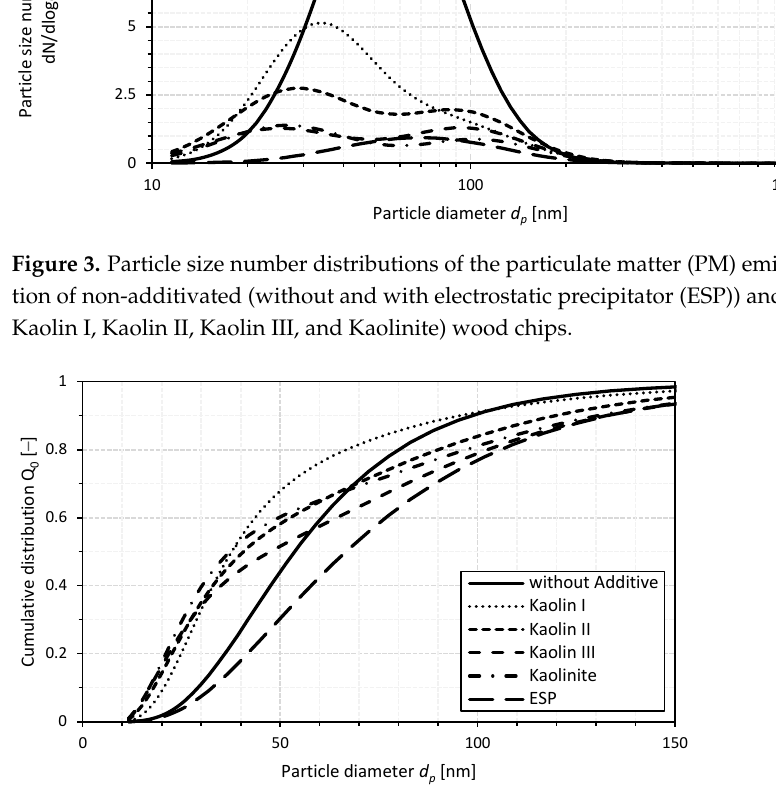
Figure 4. Cumulative particle size number distributions of the particulate matter emissions (PM) for the combustion of non-additivated (without and with electrostatic precipitator (ESP)) and additivated (0.5 wt% Kaolin I, Kaolin II, Kaolin III, and Kaolinite) wood chips (Q 0 : cumulative distribution of the quantity type “number” determined by mobility and optical analysis) .